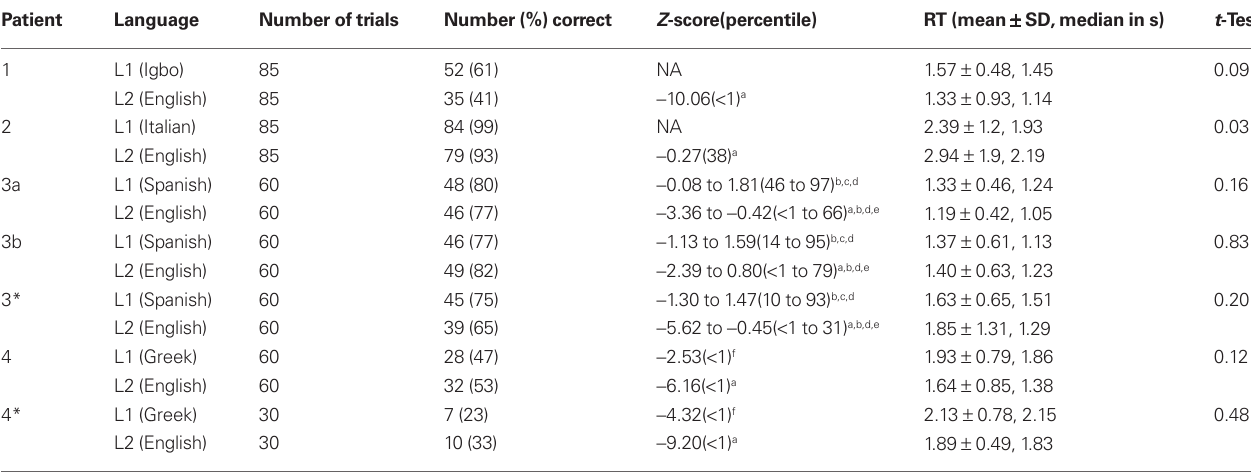
Table 2 | BNT scores (number and percent correct) during ECoG spectral mapping, Z -scores compared to published normative data, mean ± SD and